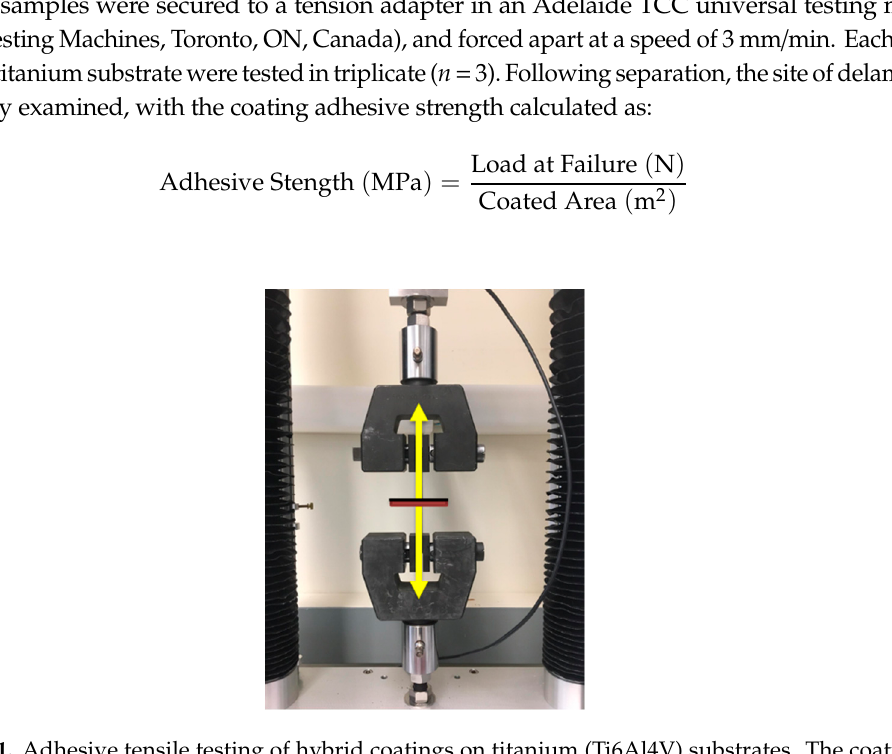
Figure 1. Adhesive tensile testing of hybrid coatings on titanium (Ti6Al4V) substrates. The coating (black line) and Ti6Al4V substrate (red line) are forced apart (yellow arrows) in an Adelaide TCC universal testing machine.